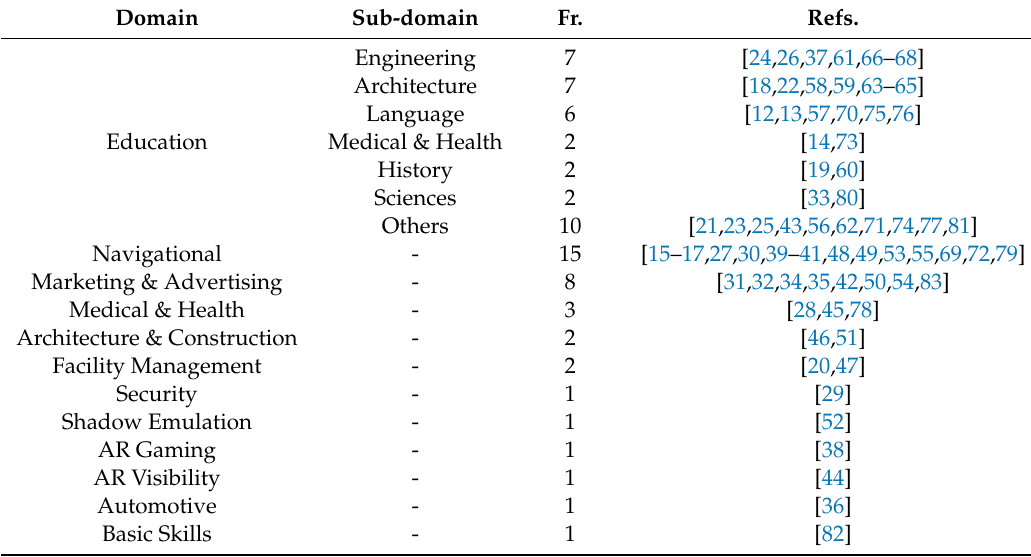
Figure 3. Research domains. Table 6. Research domains and sub-domains.